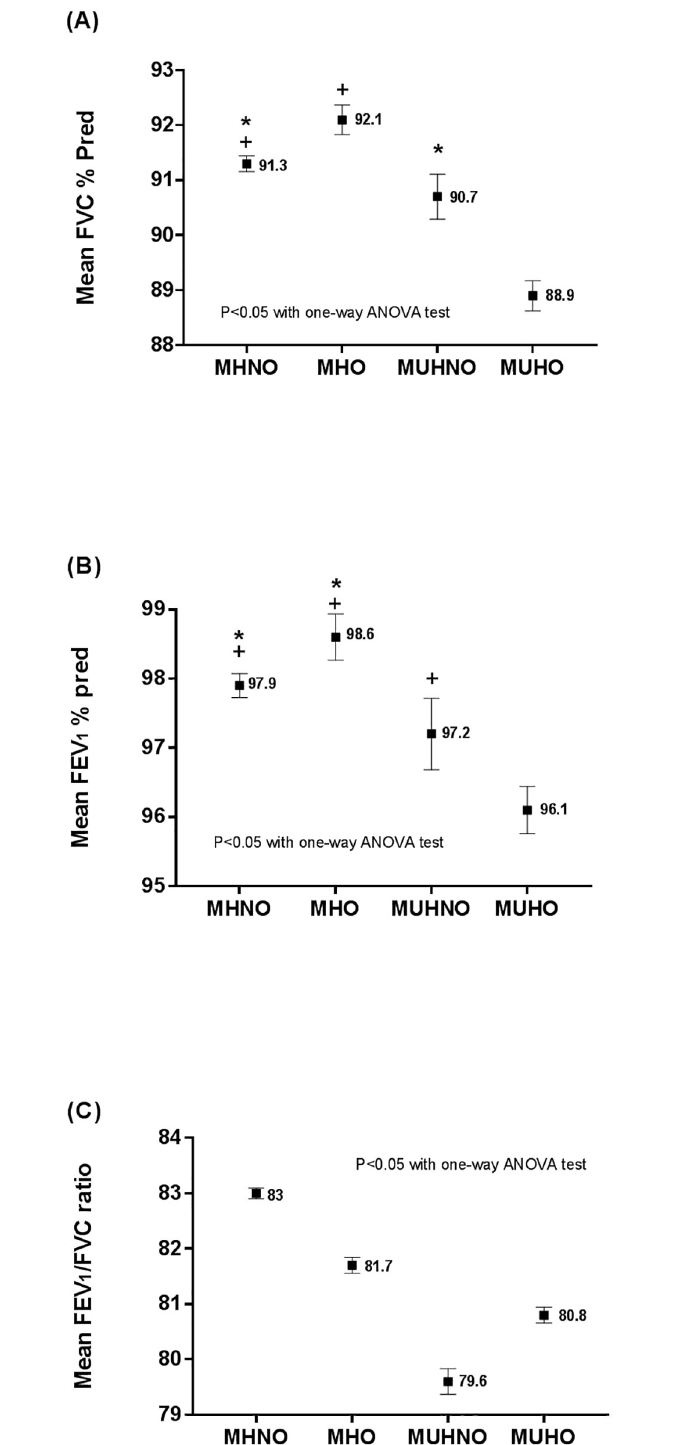
Fig 1. Lung function among the groups divided according to metabolic health and obesity status. (A) Mean FVC (% pred), (B) Mean FEV 1 (% pred), (C) Mean FEV 1 /FVC ratio. FEV 1 = forced expiratory volume in 1 s; FVC = forced vital capacity. � , + Same footnotes denote no differences between the designated